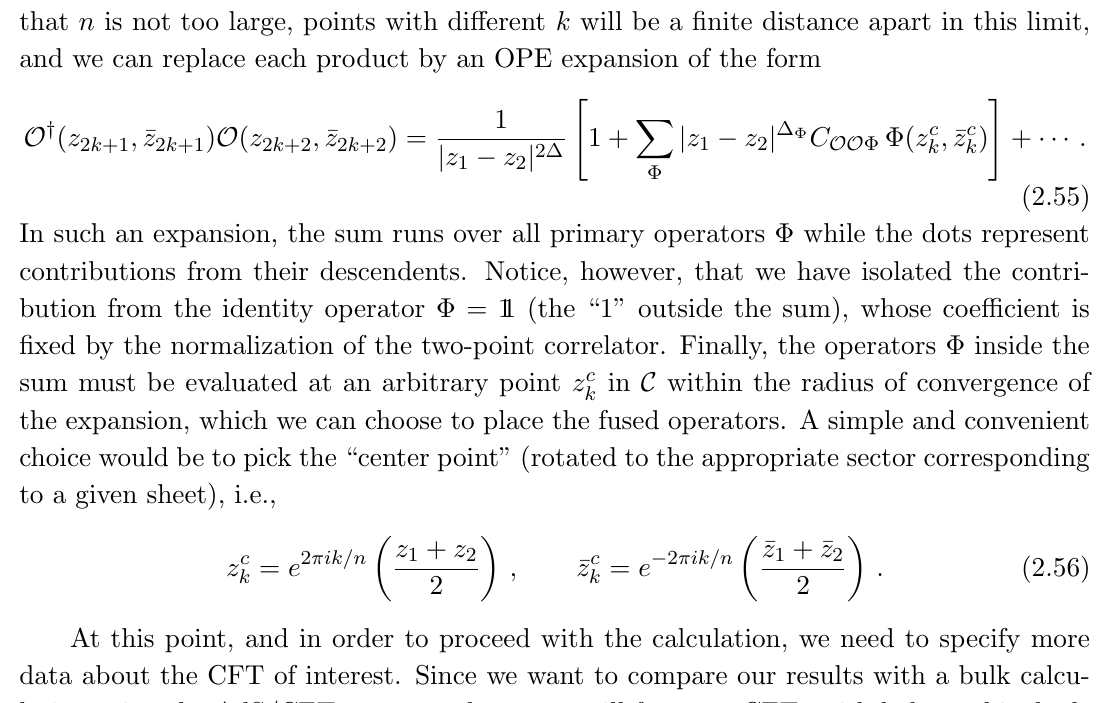
Figure 2 . Small interval limit of the 2 n -correlator in the complex plane C . Assuming R ! 0 all pairs of insertion points with equal k (i.e., in the same sheet of the original Riemann surface (cid:6) A approach to each other and one can carry out an OPE expansion between the two. This is possible provided that n is not too large, so points with di(cid:11)erent k are still a (cid:12)nite distance away from each other as R ! 0. For this plot we have set n = 12 as an illustration, but for our particular calculation we are interested in smaller values of n , speci(cid:12)cally, in the vicinity of n (cid:25)